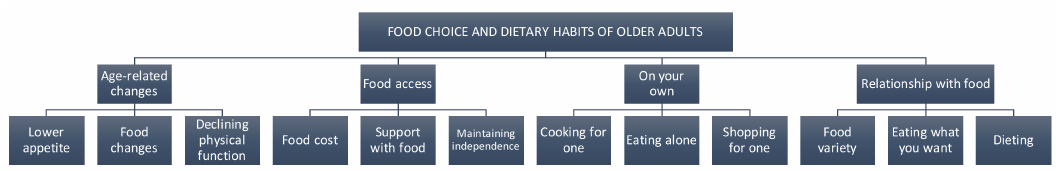
Figure 1. Older adults’ food choice and dietary